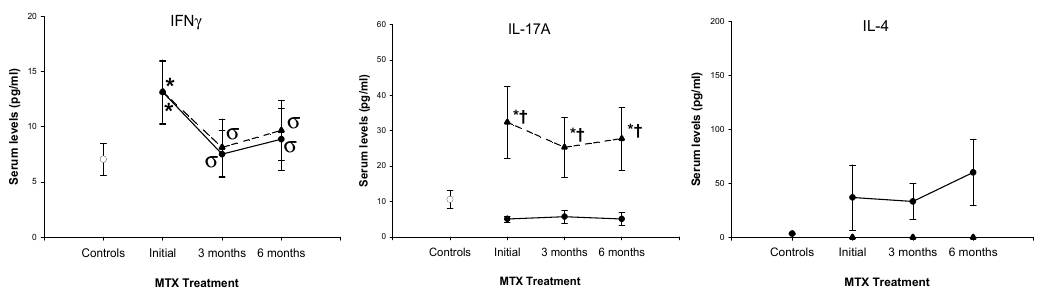
Figure 7. IFN γ , IL-4 and IL-17A serum levels in RA patients according to MTX response. Note: Data represent the mean value of serum levels of IFN γ , IL-4 and IL-17A in ( ) nonresponder, ( ) responder RA patients and ( ) healthy controls. All values are expressed as the mean serum levels ±